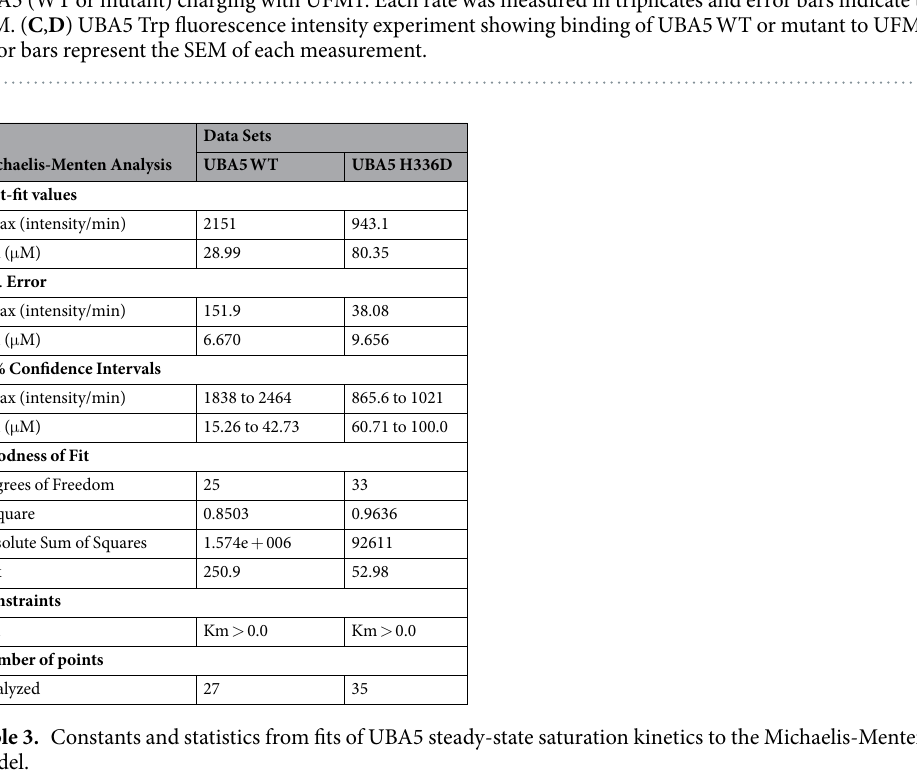
Non-covalent interactions that form homo-dimers of UBLs are not common. However, here we unexpectedly found that in solution a fraction of UFM1 exists as dimer. By solving the crystal structure of UFM1 alone and